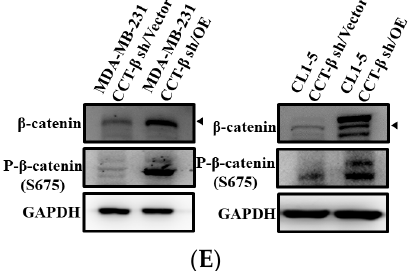
Figure 3. Correlation of XIAP and β -catenin expression with CCT- β expression. ( A ) Expression levels of XIAP in the breast cancer and lung cancer cell lines by western blotting analysis. ( B ) Lower expression levels of XIAP caused by CCT- β knockdown in the MDA-MB-231 and CL1-5 cells. ( C ) Higher expression levels of XIAP induced by overexpression of CCT- β in the CCT- β knockdown cells. ( D ) Lower expression levels of β -catenin caused by CCT- β knockdown in the MDA-MB-231 and CL1-5 cells. ( E ) Higher expression levels of β -catenin and S675-phosphorylated β -catenin were induced by overexpression of CCT- β in the knockdown MDA-MB-231 and CL1-5 cells.